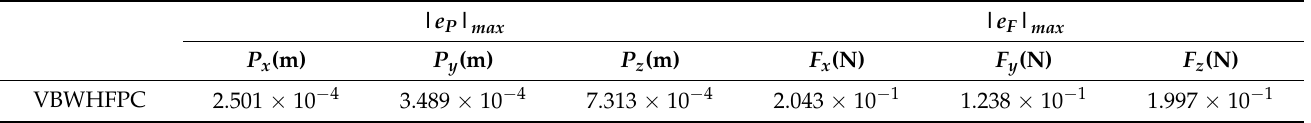
Table 5 indicates that the position and force accuracies of VBWHFPC in the Y- and Z-axis directions are 3.489 × 10 − 4 and 7.313 × 10 − 4 m and 1.238 × 10 − 1 and 1.997 × 10 − 1